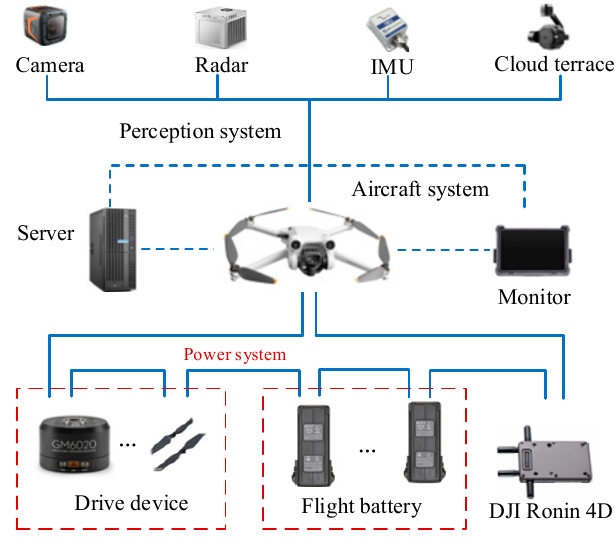
Figure 7. UAV system.